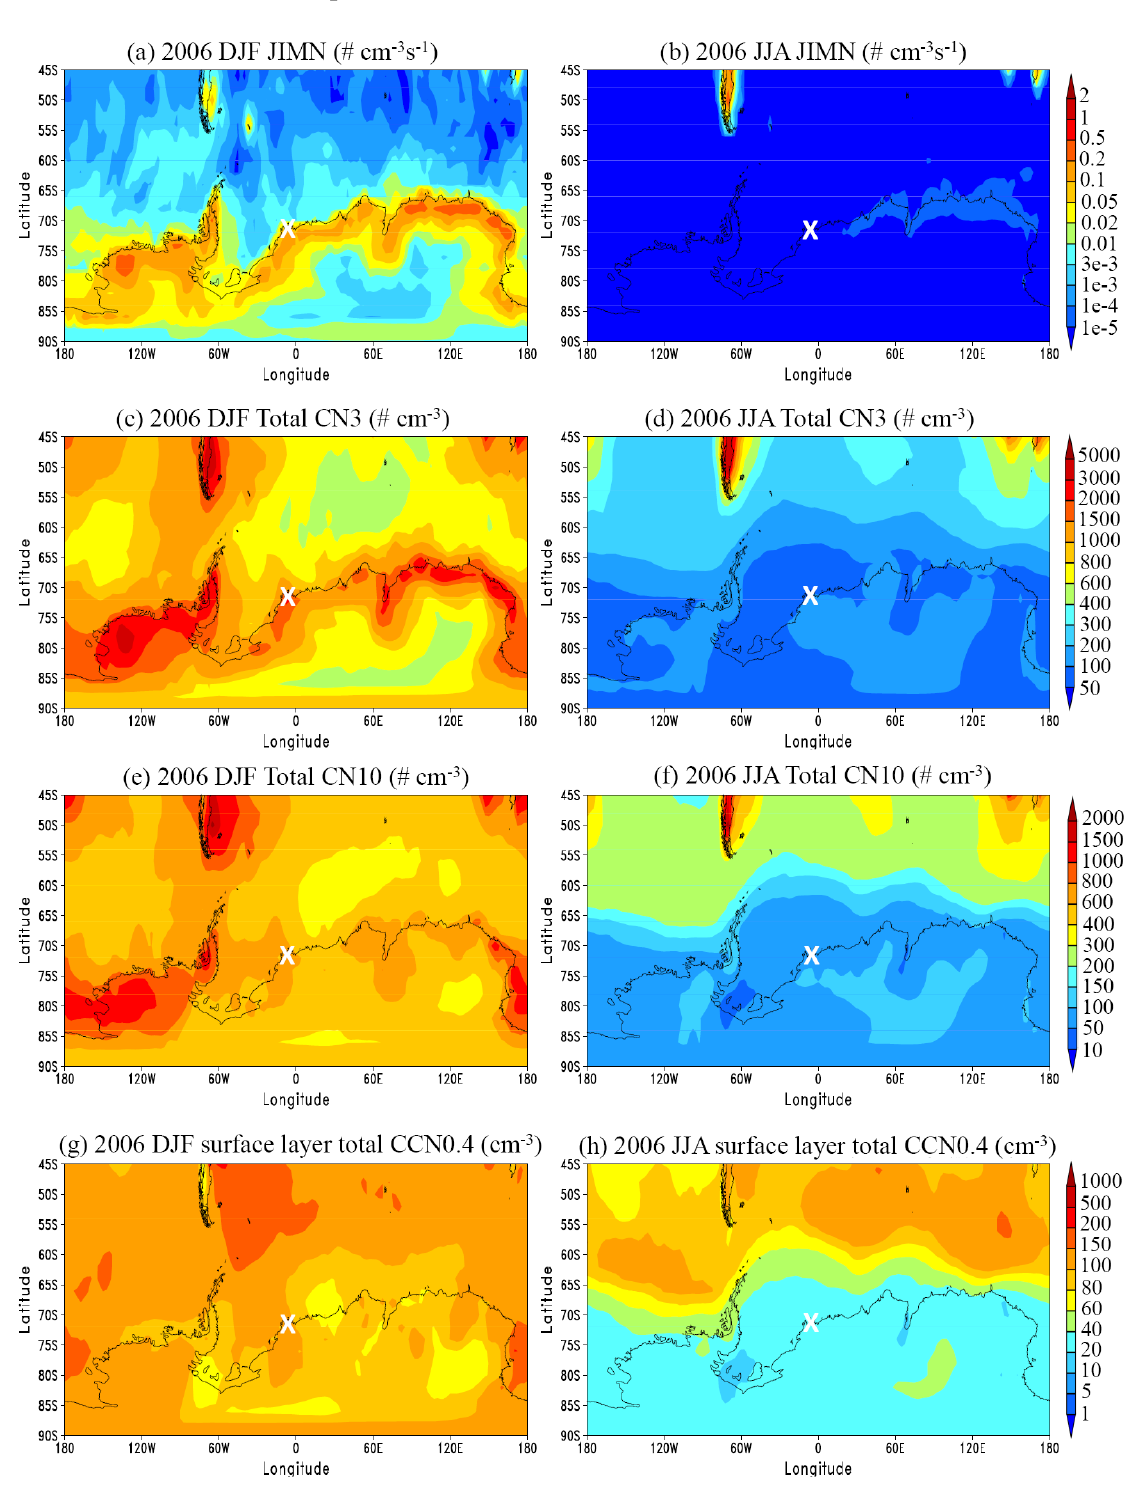
Figure 2. Simulated IMN rate (JIMN), total concentrations of the condensation nuclei larger than 3 nm (CN3) and 10 nm (CN10), and total concentrations of CCN at water supersaturation of 0.4% (CCN0.4) during the austral summer (DJF) and winter (JJA) seasons (seasonally-averaged for year 2006) in the surface layer over Antarctica and surrounding oceans. The location of the German Neumayer station (70°40’S, 008°16’W) is marked with “X” in each